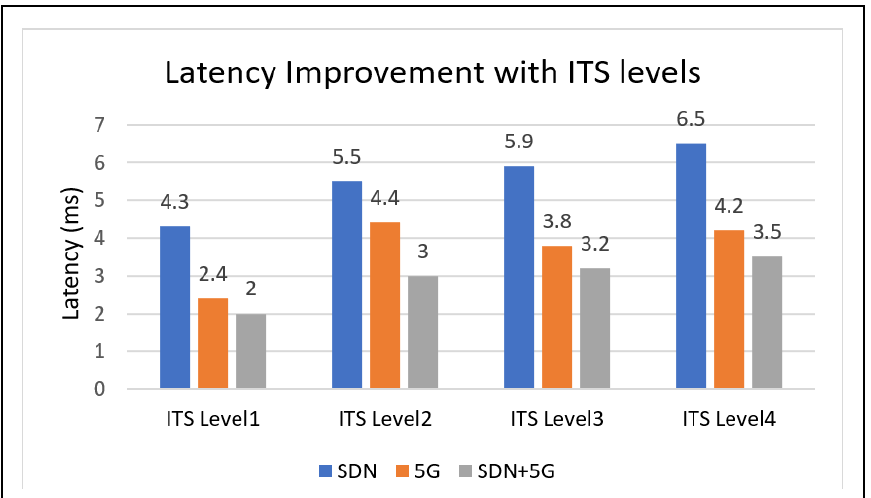
Figure 6. Comparison of EE with the levels of ITS.